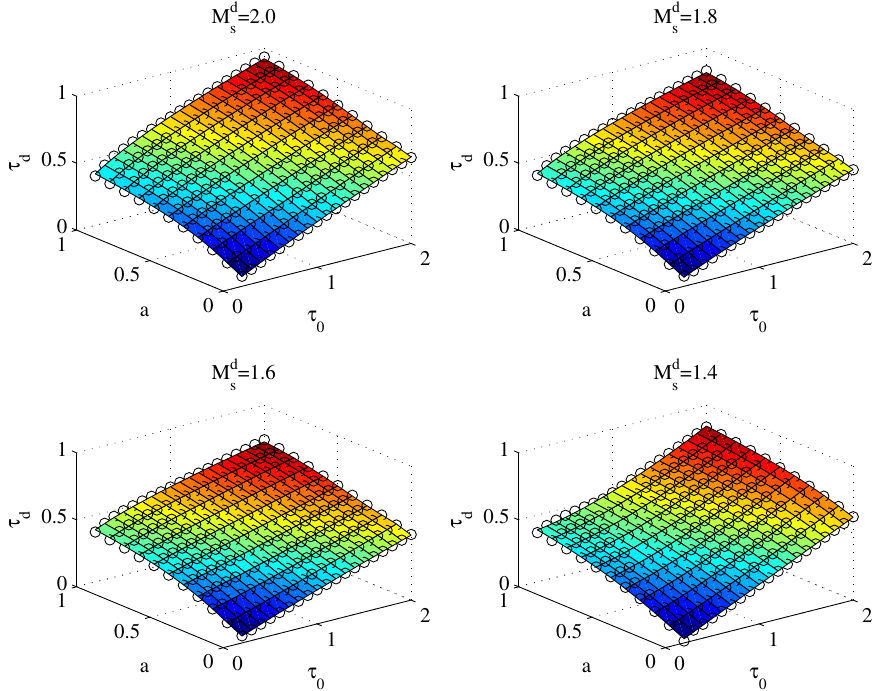
Figure 3. Calculated and approximated optimal τ d in the servo